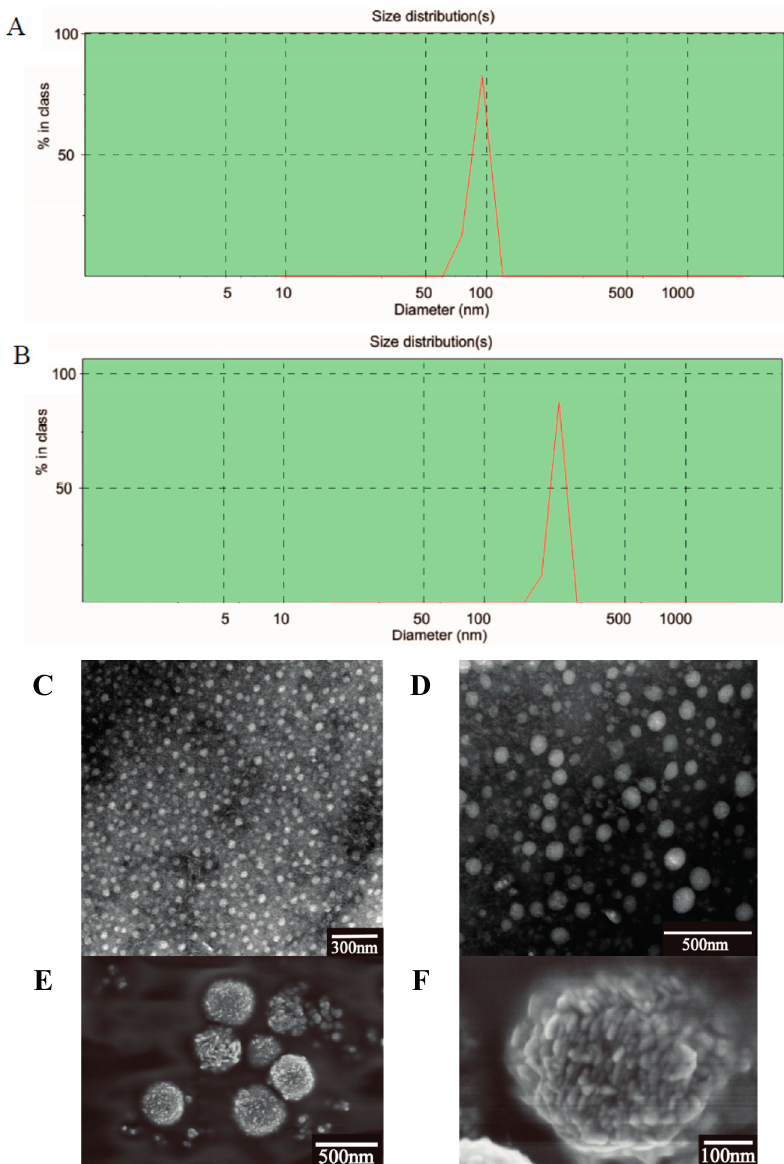
Figure 3. Malvern Zetasizer 3000 HSA size measurement of ( A ) blank micelles, ( B ) PTX-loaded GA micelles. TEM images of bare micelles ( C ) and PTX-loaded GA micelles ( D ). SEM images of PTX-loaded GA micelles ( E , F